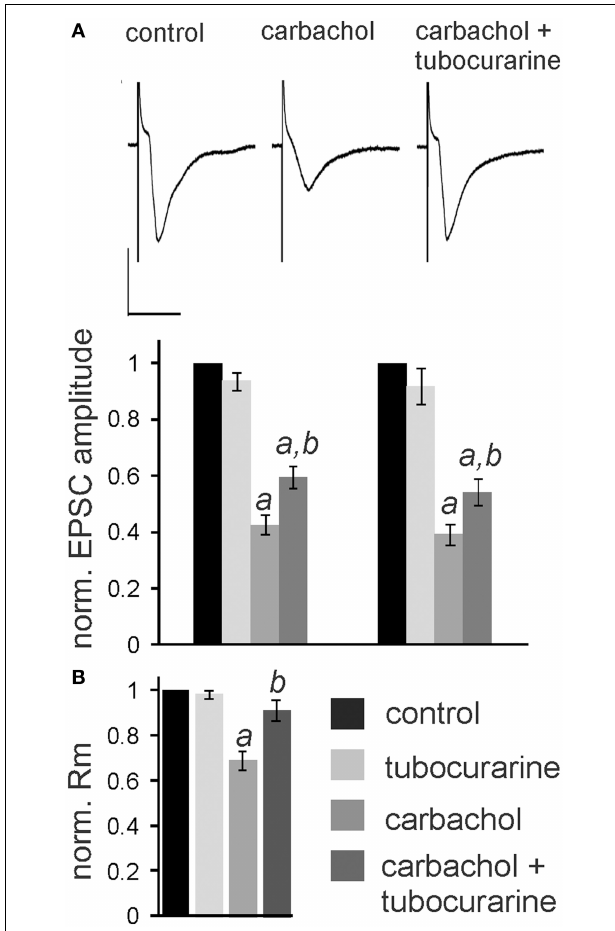
FIGURE 6 | Tubocurarine partly reverses the effect of carbachol on PnC giant neurons. (A) , top : Exemplary traces of trigeminally evoked synaptic currents during perfusion of tubocurarine, carbachol, and the two drugs combined. Bars indicate 25ms (horizontal) and 100 pA (vertical). Bottom : The perfusion of 50 μ M tubocurarine had no effect on synaptic currents, whereas 10 μ M carbachol significantly reduced synaptic current amplitudes. When tubocurarine application was combined with carbachol, the reduction of synaptic currents was significantly smaller than with carbachol alone ( n = 10 cells for tubocurarine and tubocurarine plus carbachol, n = 14 cells for carbachol alone). Significant differences to control are labeled by “ a ,” significant differences to the carbachol condition are labeled by “ b .” (B) Membrane resistance (Rm) normalized to the resistance of each cell under control condition. Tubocurarine had no effect on Rm, whereas the application of carbachol significantly decreased Rm. The additional application of tubocurarine completely reversed this effect ( n = 10 cells).